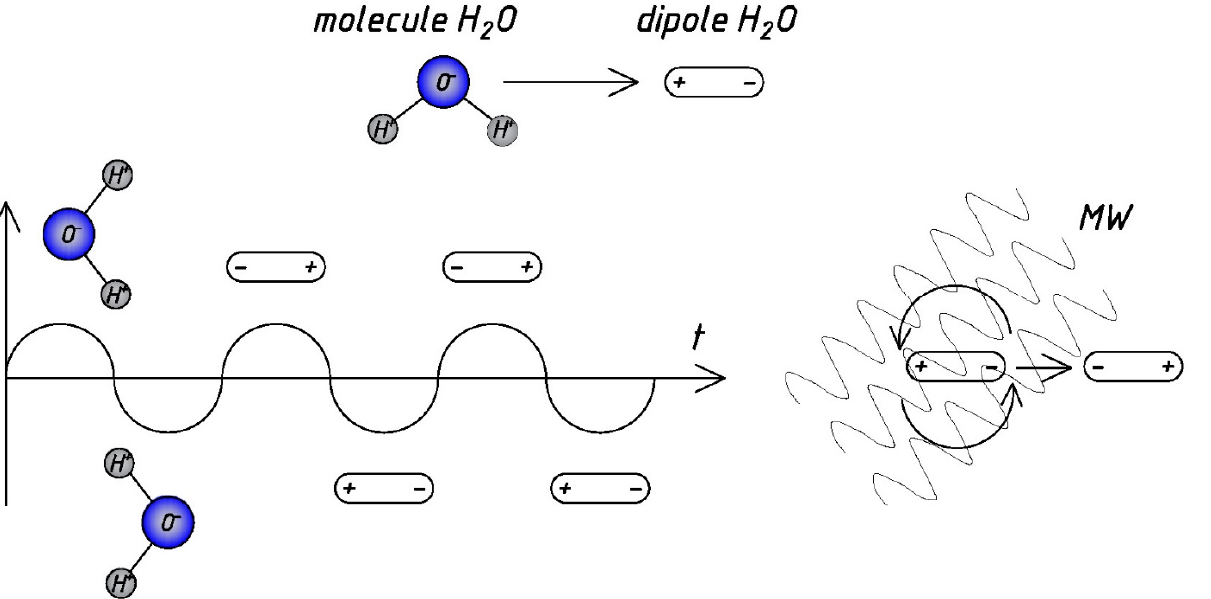
( с ) Figure 2. Dependence of temperature on the time of MW-heating of: ( a ) faecal sludge in Kenya, 100 g sample [27] ; ( b ) faecal sludge in Kenya, 200 g sample [27] ; and ( c ) active sludge in China Reprinted with permission from ref. [25]. As a rule, the efficiency of the MW system tends to rise with the increase of power and time of microwave irradiation [22]. It is due to the release of extra heat, contributing to the rapid movement of water molecules. In addition, increased time and power of irra- diation amplify the decomposition of various contaminants in the water environment [9]. Contact time Contact time